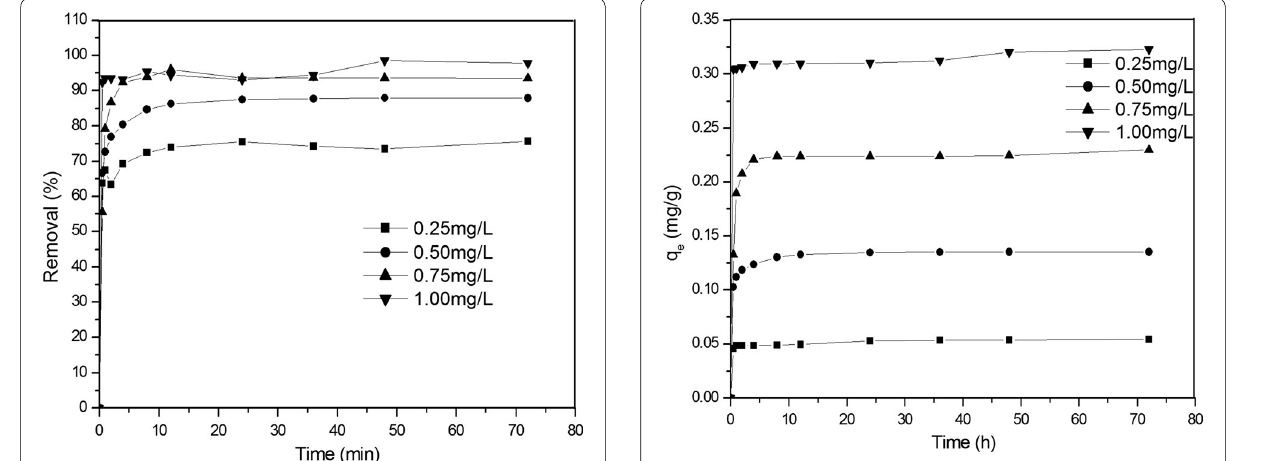
Fig. 2 Removal kinetics for As with activated